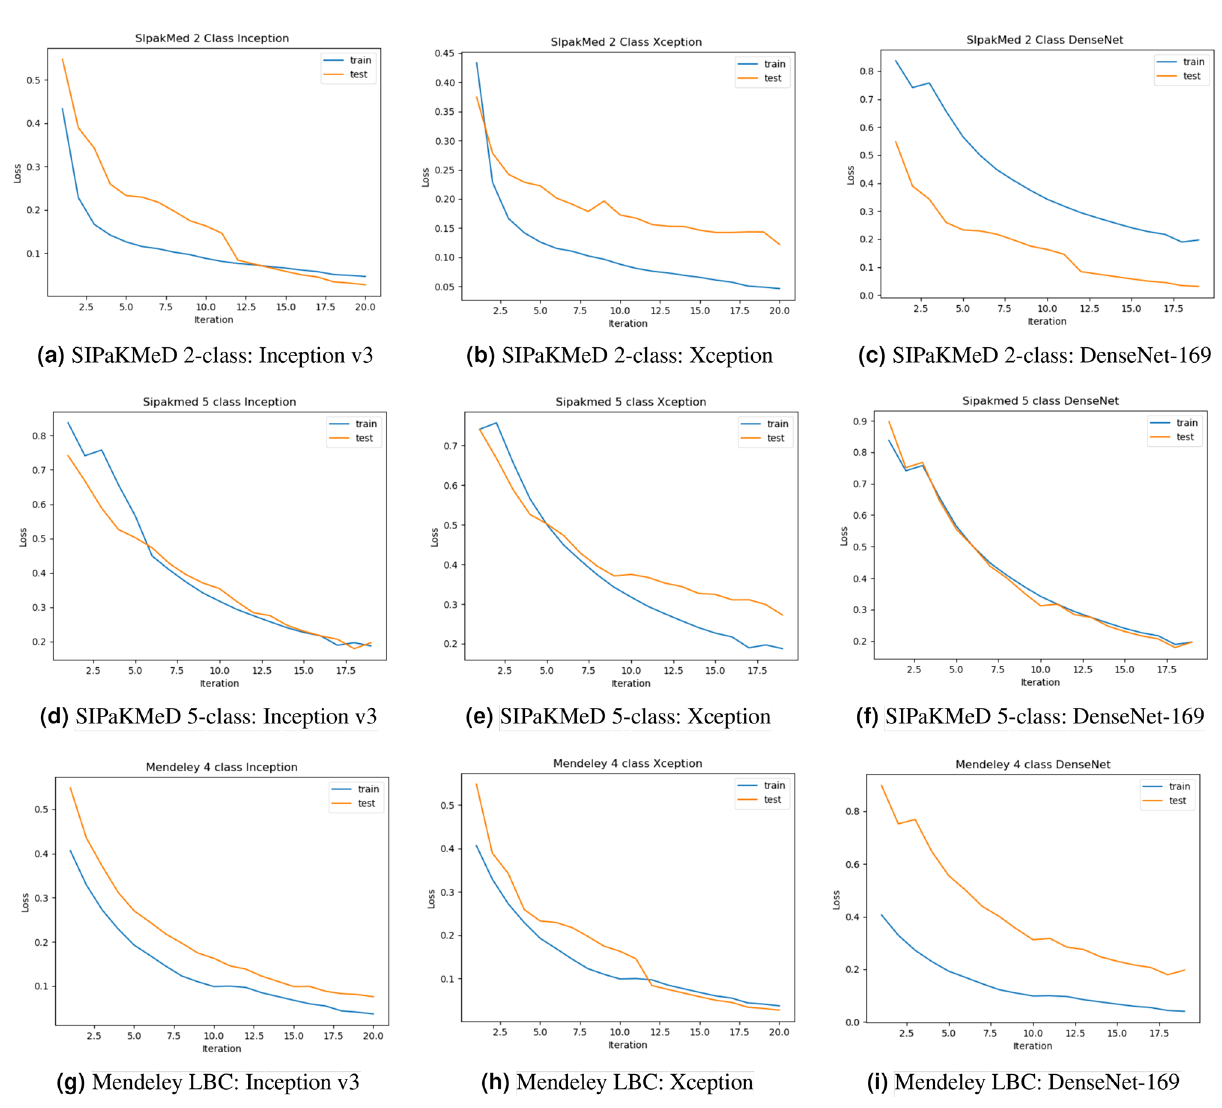
Figure 13. Loss curves obtained on fine-tuning the three CNN base learners: Inception v3, Xception and DenseNet-169 on the three datasets used in this research— (a–c) SIPaKMeD 2-class dataset, (d–f) SIPaKMeD 5-class dataset and (g–i) Mendeley LBC 4-class dataset (The loss curves have been plotted using Keras framework of Python).